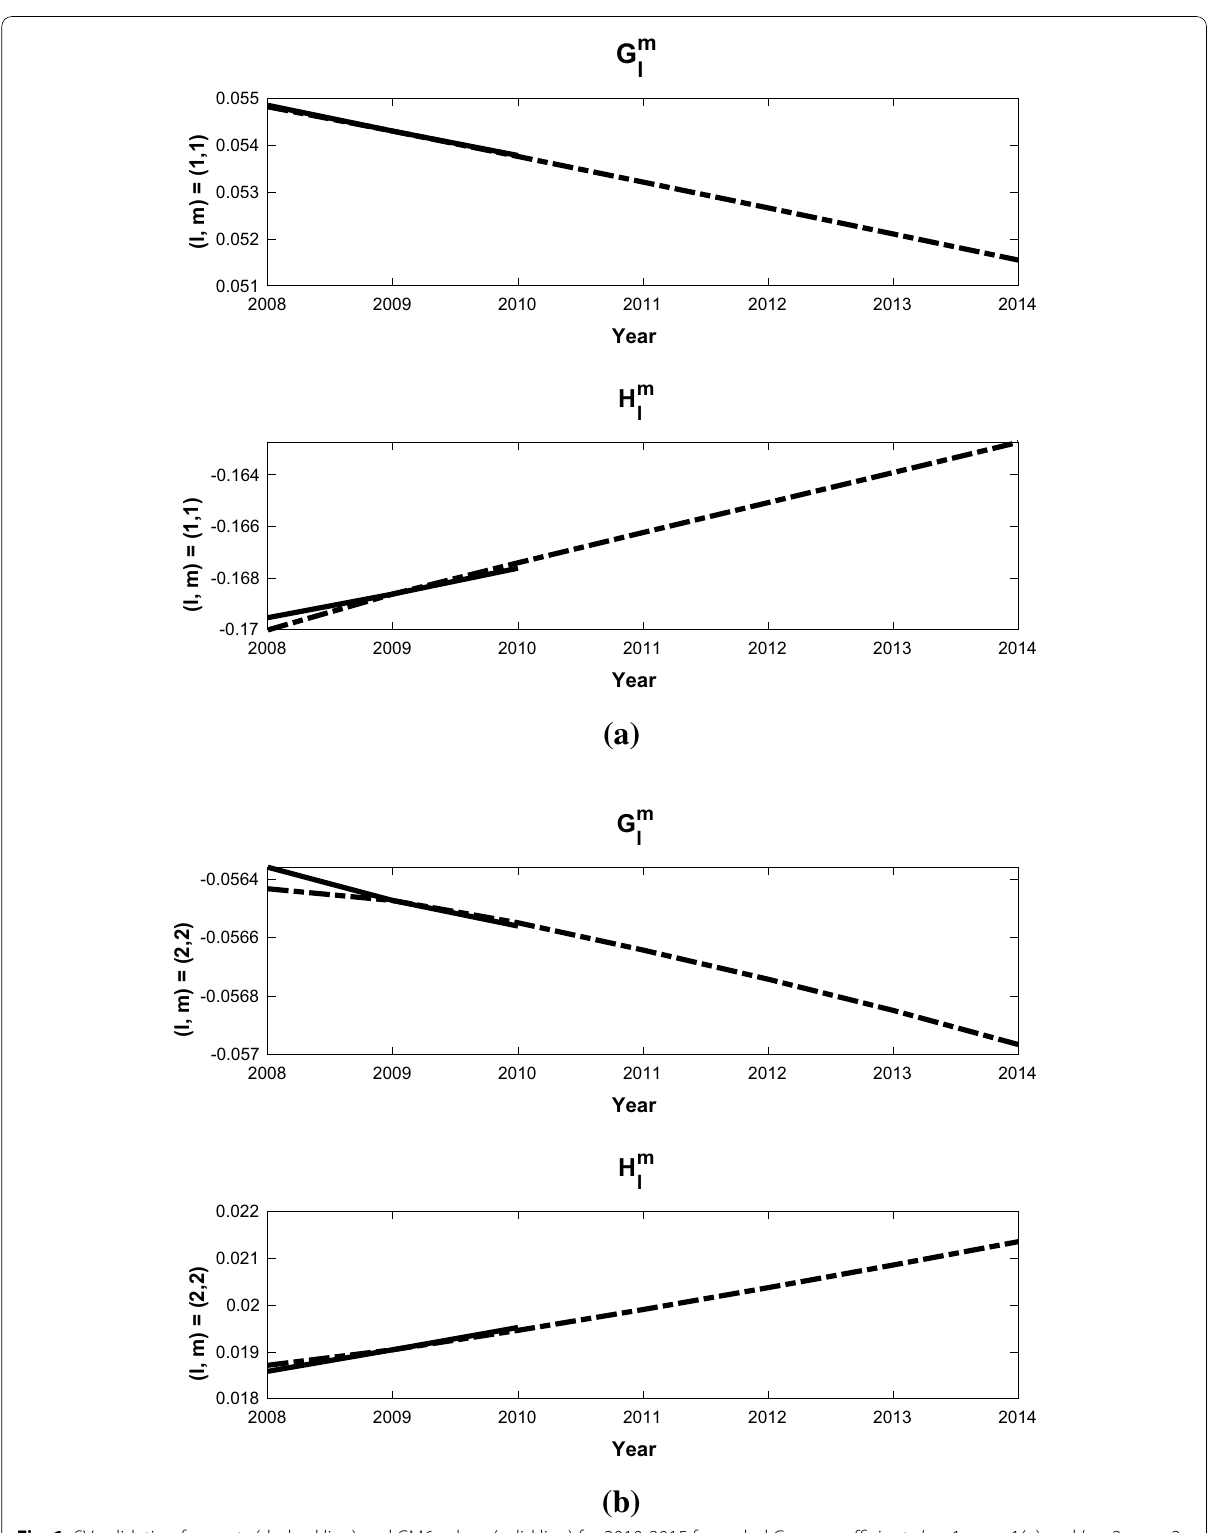
Fig. 1 SV validation forecasts (dashed line) and CM6 values (solid line) for 2010-2015 for scaled Gauss coefficients l = 1, m = 1 ( a ) and l = 2, m = 2 ( b ) ( G m l , H m l ) normalized using g 0 1 from 2009. The resulting SV values are shown in Table